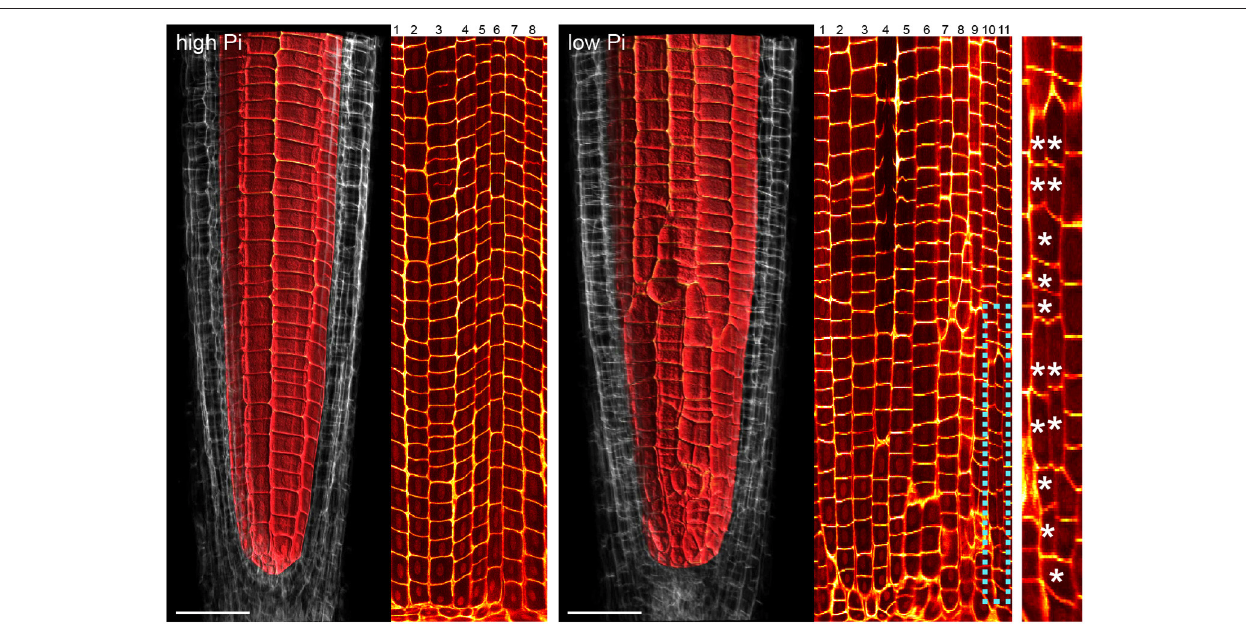
FIGURE 5 | Cell lineage analyses reveal multiple cell division events leading to increases in radial anticlinal cortical cell file number. Unrolled images showing cell lineages in the cortex of Arabidopsis roots under high Pi (Left) and low Pi (Right) . Using Adobe After Effects we digitally dissected the membranes between cortex cells. In ImageJ. We unrolled this data set in order to visualize the cortical cell lineages within the root meristem. The dissected cell layers unrolled are shown in Supplemental Movie 2. Whilst 8 continuous cell files can be traced from just above the quiescent center until the start of the elongation zone for plants grown on high Pi, when grown on low Pi, we observe multiple events in which CCFN is increased in relatively small numbers of cells. These events are marked with asterisks. Scale bars = 50 µ